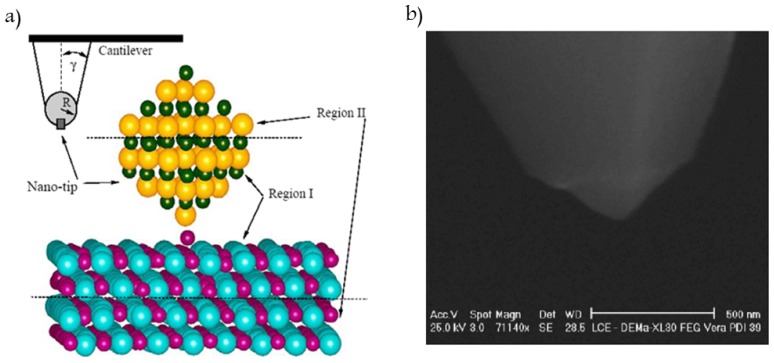
(a) Scheme for the integration of macroscopic and AFM tip (Reproduced by permission of IOP Publishing Ltd. [80]); (b) SEM image of a sharpened pyramidal tip (Reproduced by permission of Taylor and Francis Ltd. [81].